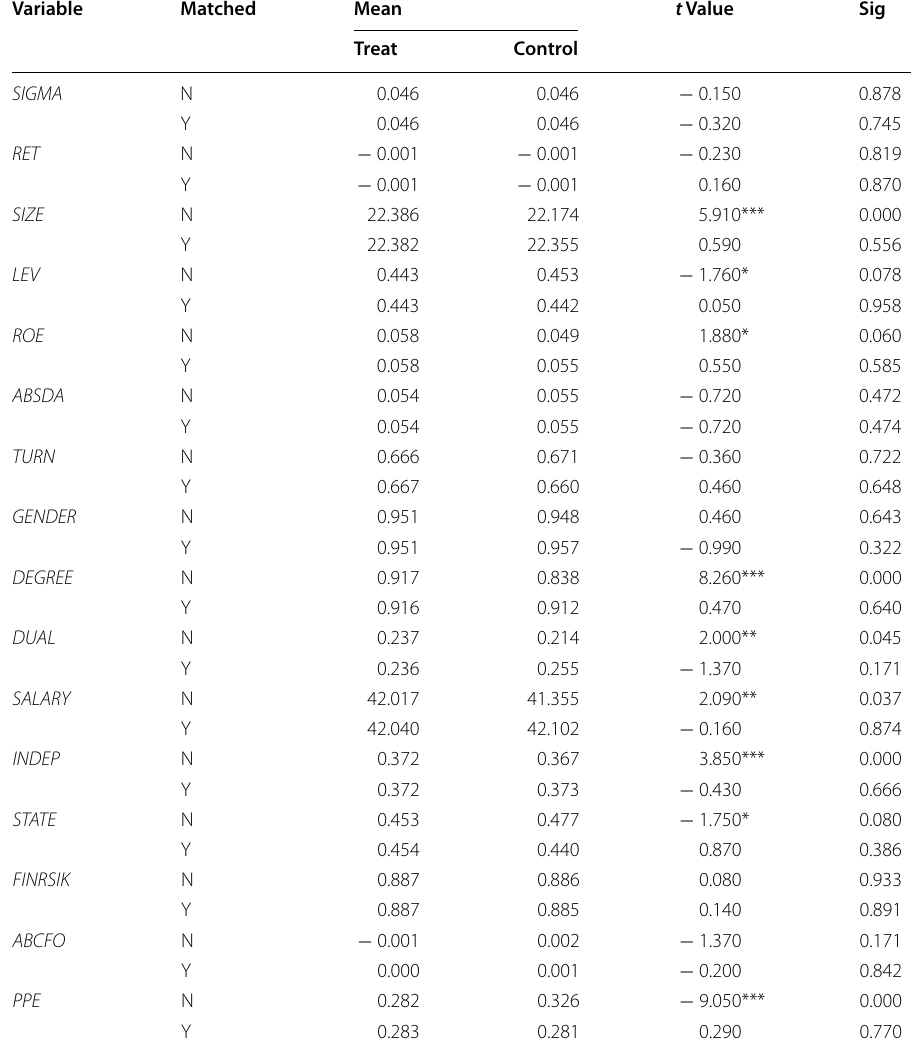
Table 2 The differences between samples before and after matching Variable